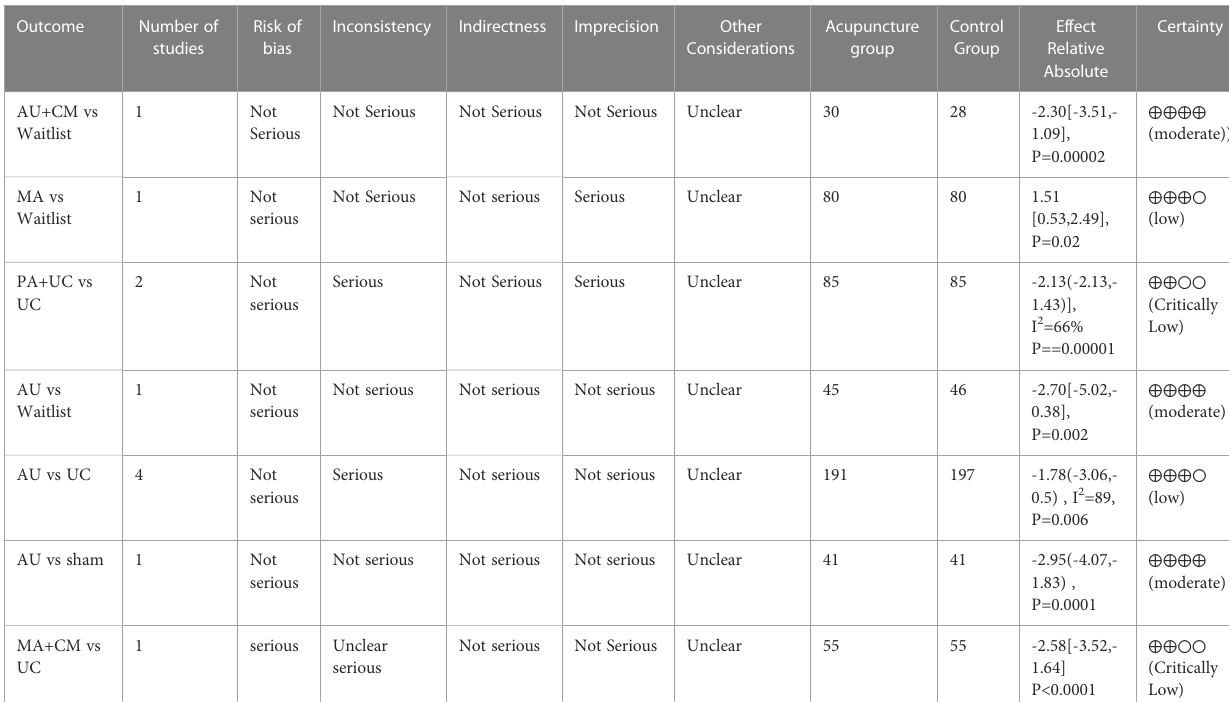
TABLE 7 Quality of evidence of PSQI in network meta-analysis.